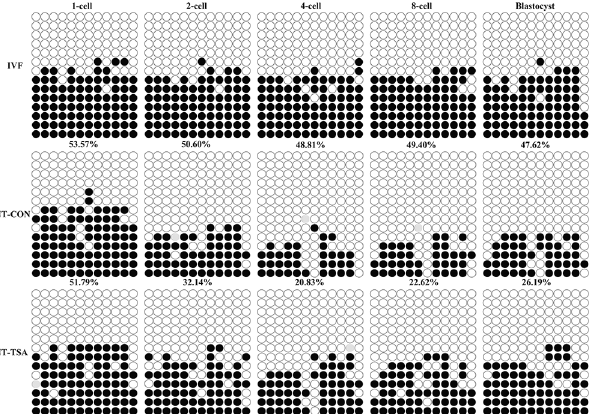
Fig 1. H19/Igf2 methylation statuses in early embryos. The methylation statuses of H19/Igf2 at 1-cell, 2-cell, 4-cell, 8-cell and blastocyst stages of IVF, NT-CON and NT-TSA embryos were examined. Cloned embryos displayed aberrant imprinting of H19/Igf2, while TSA rescued the disrupted imprinting in cloned embryos. Black or white circles indicate methylated or unmethylated CpG sites, respectively, and gray circles represent mutated and/or single nucleotide polymorphism (SNP) variation at certain CpG